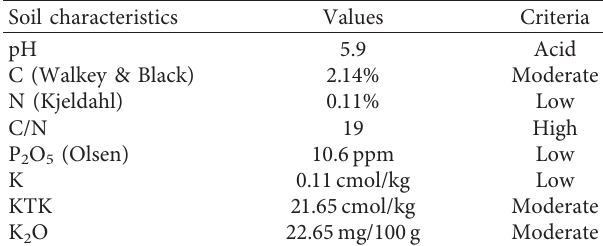
Table 1: Summary of soil